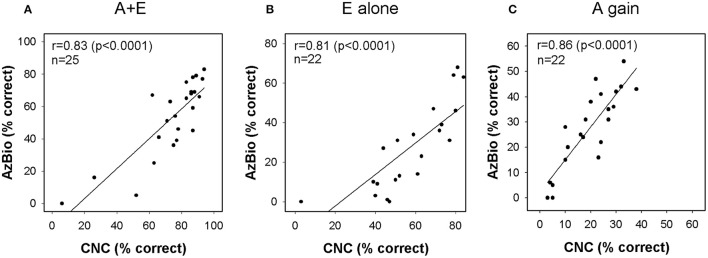
Relationship between CNC and AzBio performance in (A) A+E, (B) E alone, and (C) A gain conditions. Each column plots the AzBio sentence scores as a function of CNC word scores. CNC indicates consonant-nucleus-consonant; A, acoustic; E, electric.